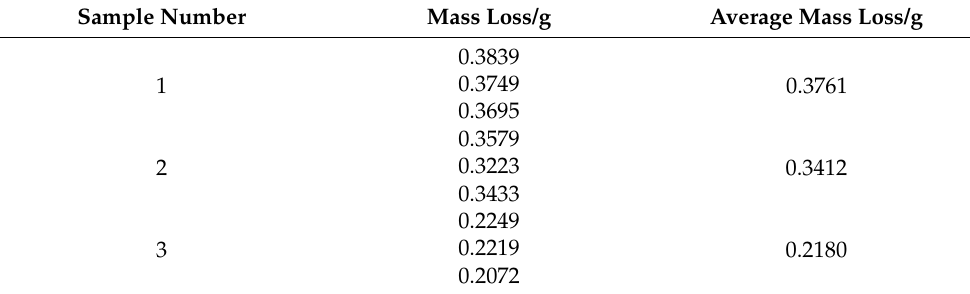
Table 8. Erosion wear test results.